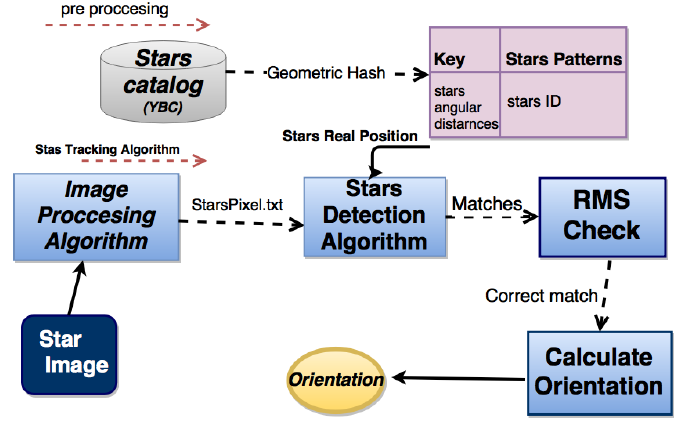
Figure 2. The main components of the Star-Tracking